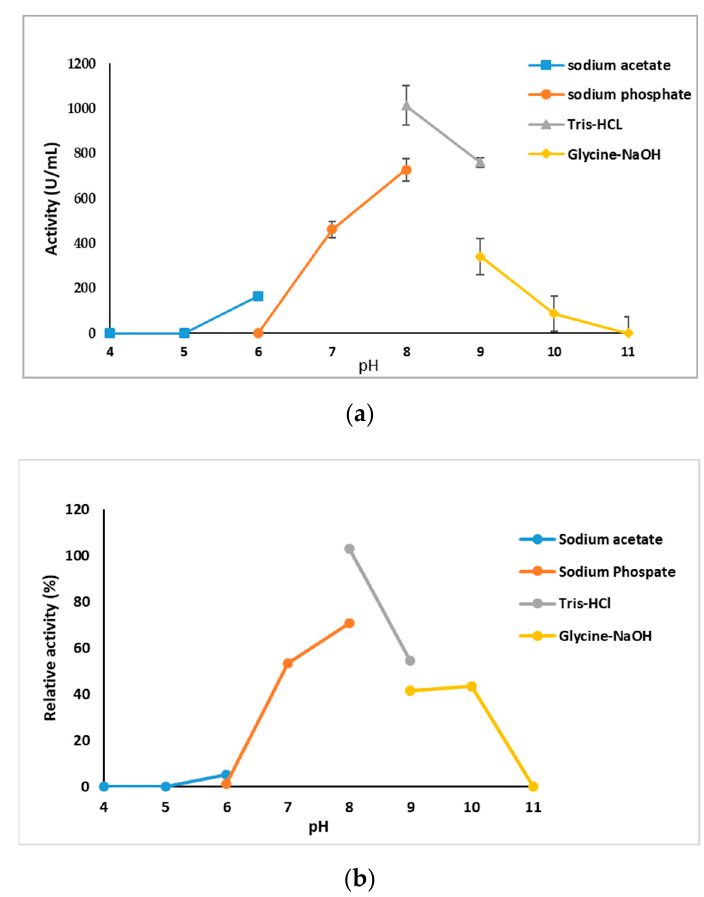
Figure 5. Effect of purified GlaEst12 esterase on enzyme ( a ) activity and ( b ) stability. The optimal pH was determined by measuring enzyme activity using pNP (C10) as a substrate in different buffer systems ranging from pH 4–11. The pH stability was determined by incubating an enzyme at different buffers for 30 min and measuring the residual activity at optimum pH. The buffer systems were used: sodium acetate (pH 4–6) (blue, filled square); sodium phosphate (pH 6–8) (orange, filled circle); Tris-HCl (pH 8–9) (grey, filled triangle), and glycine-OH (pH 9–11) (yellow, filled diamond). Error bar represents standard deviation ( n = 3). The absence of the bar indicates the error smaller than symbols.